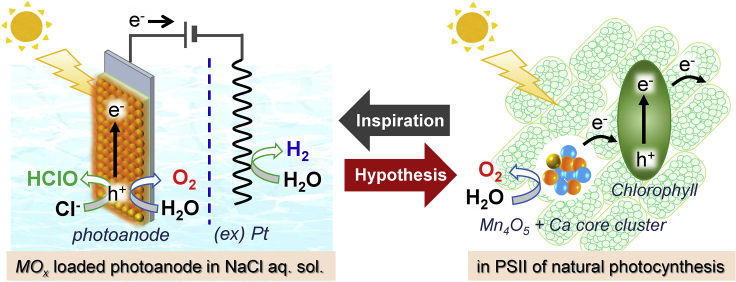
Reaction Images of the Artificial/Natural Photosynthesis SystemsReaction images of the artificial photosynthesis system using MOx-loaded BiVO4/WO3/FTO photoanode (left) and Mn4O5 + Ca core cluster for OER and chlorophyll in PSII of natural photosynthesis (right).